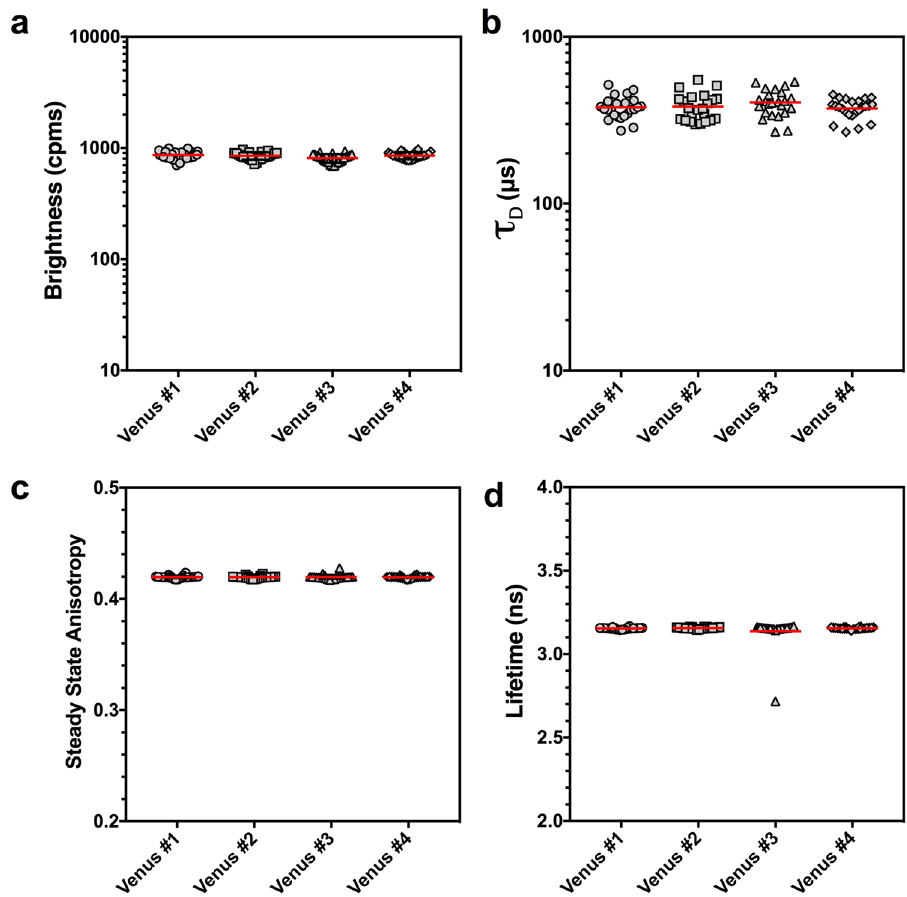
Figure 3. Auto-FPFA accuracy and reproducibility. Auto-FPFA measurements of the molecular brightness ( a ), diffusion time ( τ D , b ), steady state anisotropy ( c ), and lifetime ( d ) of Venus monomers. Four cell homogenates (circle, square, triangle and diamond symbols) were prepared from cells expressing the Venus fluorescent protein. Replicates of these homogenates were deposited in 24 different wells of a micro-titer dish and all 96- wells were measured overnight by auto-FPFA. Red bars indicate the mean of the 24 replicates of each sample. Note the outlier that is easily detected in Venus sample #3 in panel